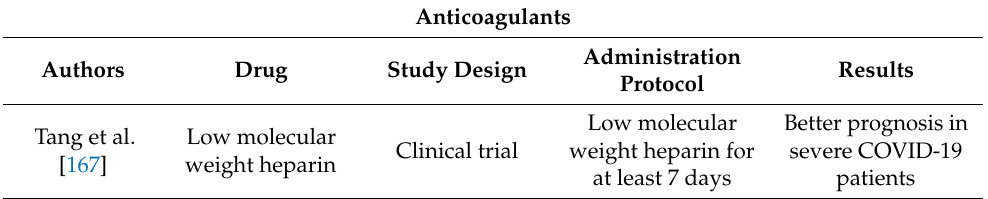
Table 7. Summary of the in vivo studies included in anticoagulants treatments for viral